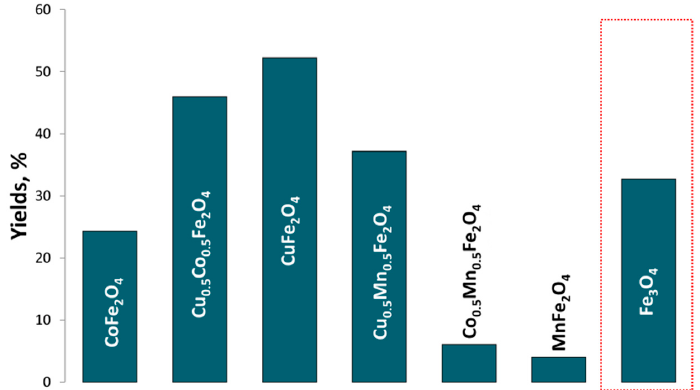
Figure 5. Integrated yields for H 2 produced during second reoxidation step carried out with steam at 450 °C and MFe 2 O 4 ferrospinels (note: Listed data correspond to the values obtained after 1 complete cycle of 20 min).